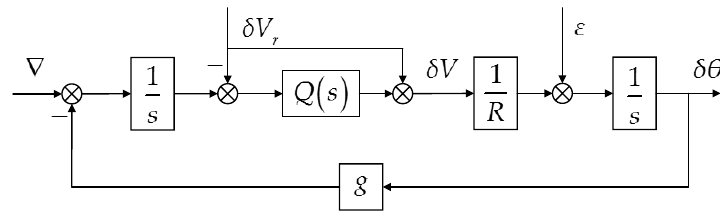
Figure 1. Error propagation of the generalized damped Schuler loop.